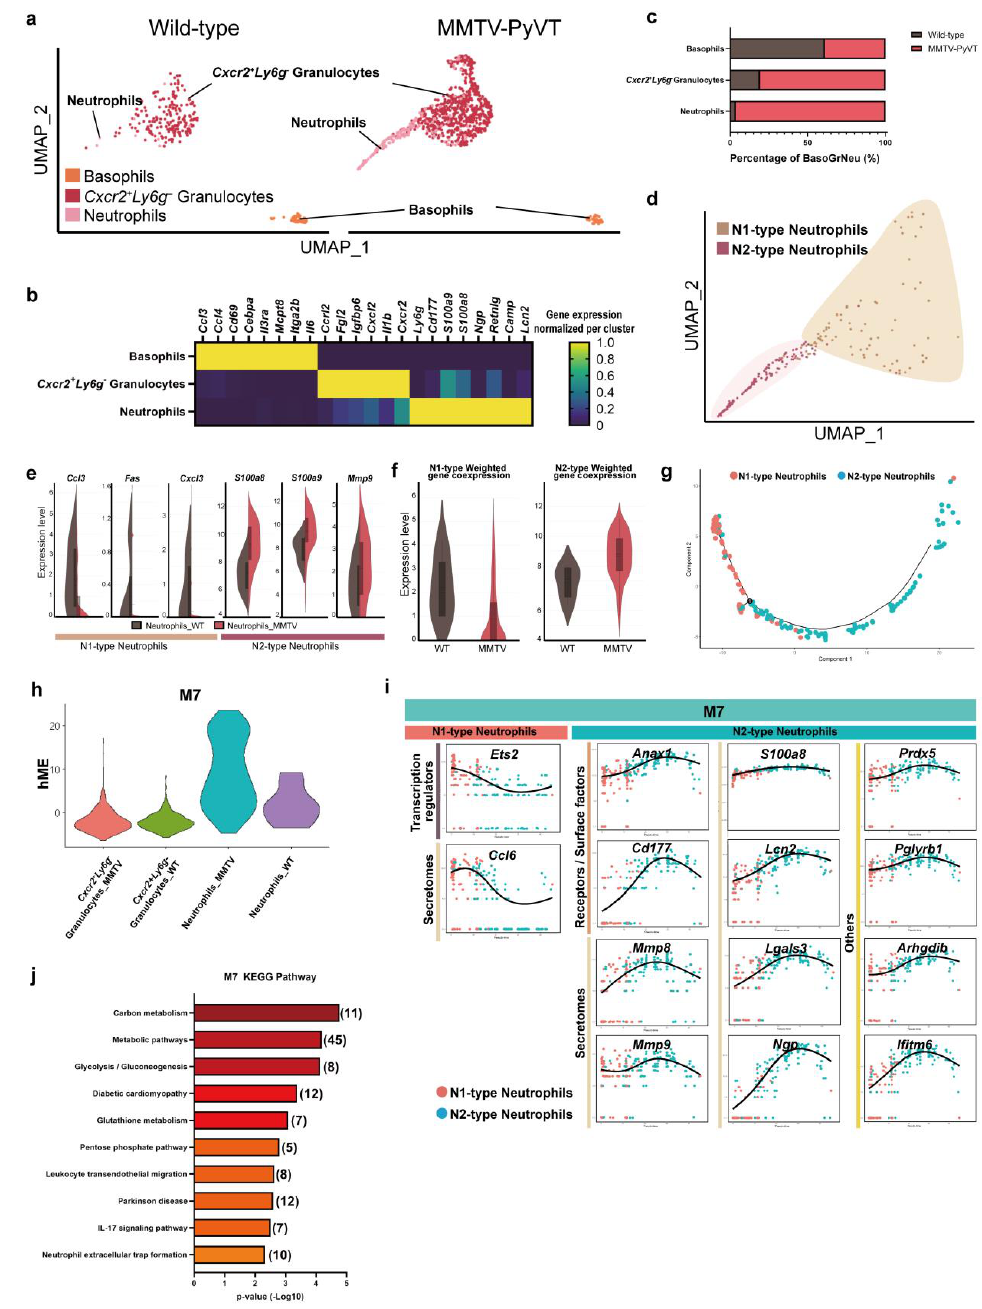
Figure 3. N2-type neutrophils identified in lung PMN. ( a ) Subpopulation of granulocytes. ( b ) Biomarkers of granulocyte subpopulations. ( c ) The cell number for granulocyte subpopulations. ( d ) UMAP analysis representing the distribution of N1- and N2-type neutrophils. ( e ) Violin plot showing the expression of N1 and N2 markers in the neutrophils of wild-type and MMTV-PyVT mice. ( f ) Weighted analysis of neutrophil phenotypes of wild-type and MMTV-PyVT mice. ( g ) Trajec- tory analysis of N1- and N2-type neutrophils. ( h ) WGCNA analysis of neutrophils in the lungs of wild-type and MMTV-PyVT mice. Each leaf (vertical line) in the dendrogram corresponded to a gene. ( i ) KEGG pathway analysis of M4 module of the WGCNA analysis. ( j ) Genes that contributed to the functional transition of N1- and N2-type